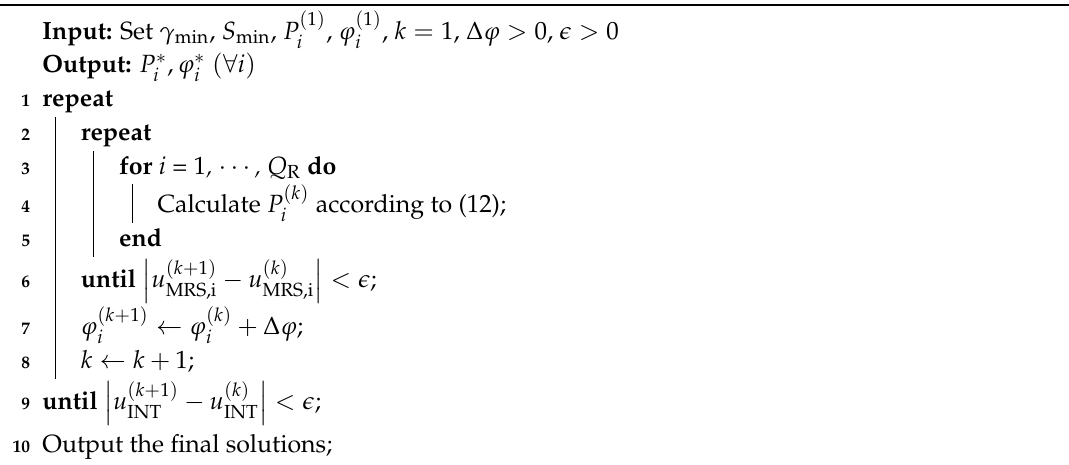
Algorithm 1: Pricing-Based Distributed Iterative Power Control Approach